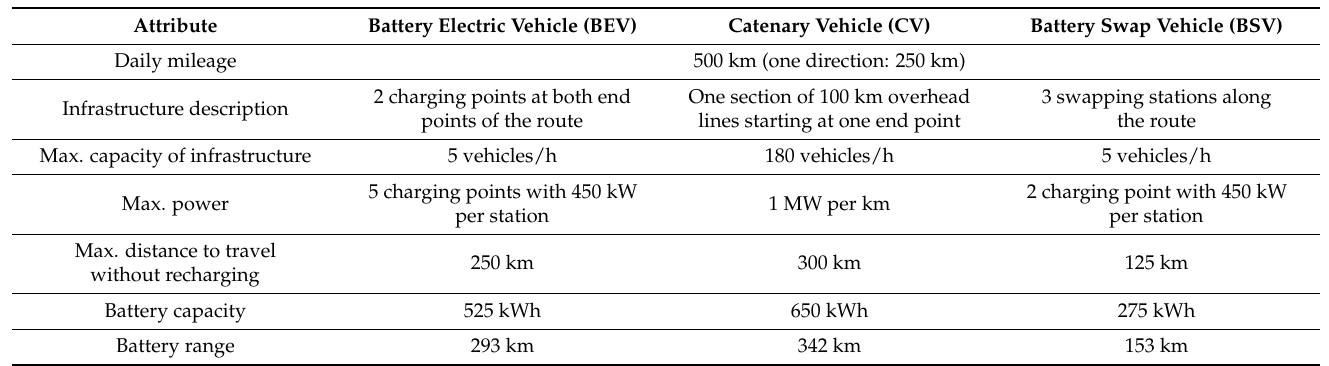
Table 1. Comparison of the different technologies (assumptions).